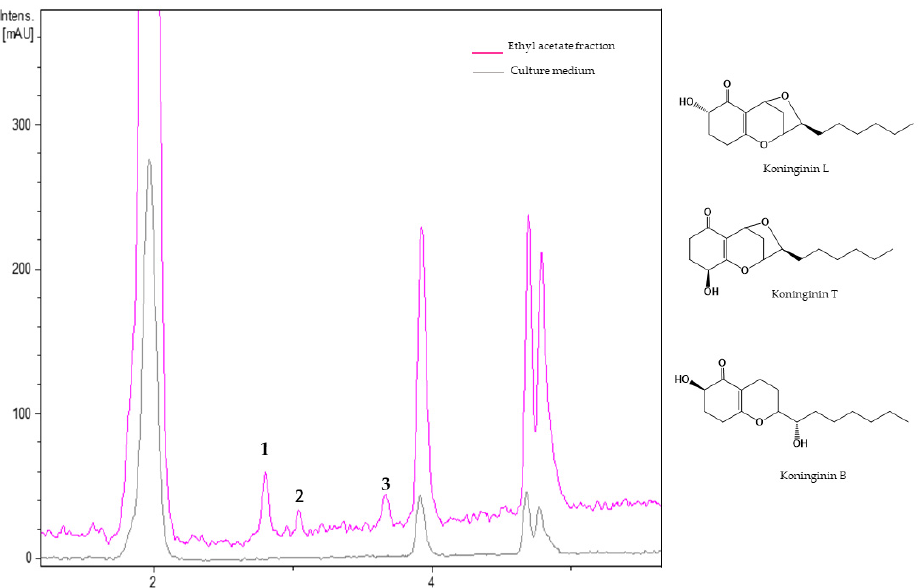
Figure 5. UV 210 nm chromatogram of residual filtrate fraction from Trichoderma koningiopsis Th41-11 and the unfermented culture medium. 1 : Koninginin T, 2 : koninginin L, 3 : koninginin B. Table 5. Dereplicated metabolites from ethyl acetate fraction of Trichoderma koningiopsis Th41-11. No.